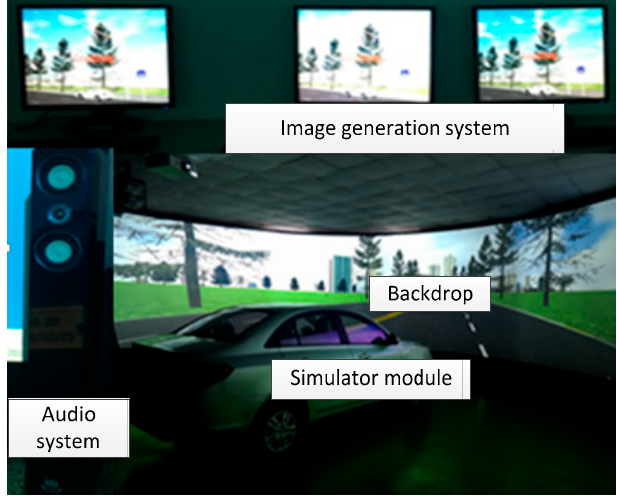
Figure 4. Driving simulator to generate simulation data.